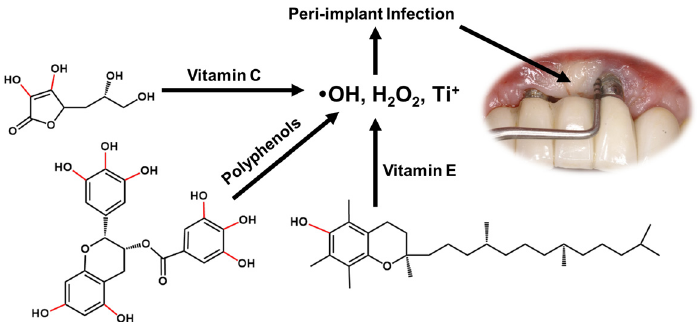
Figure 3. Antioxidants for the treatment of periodontitis during dental